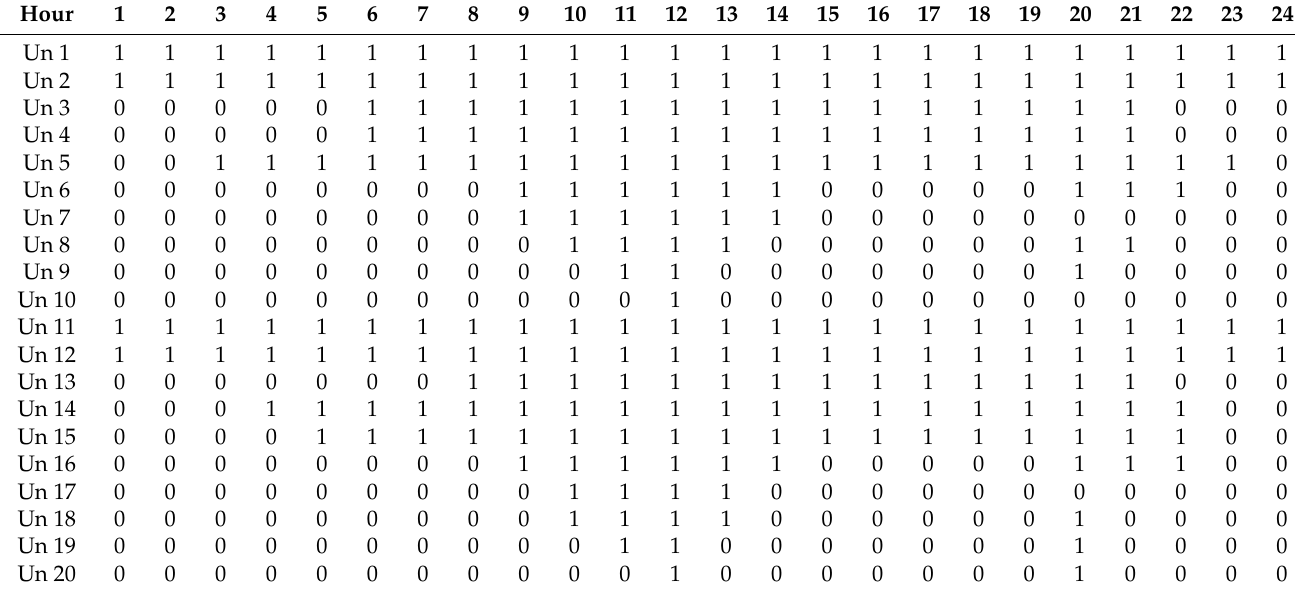
Figure 3. Performance of 10-generating units over 24 h (test system 1). Table 7. Optimal scheduled operation for the 20-unit system over 24 h (test system